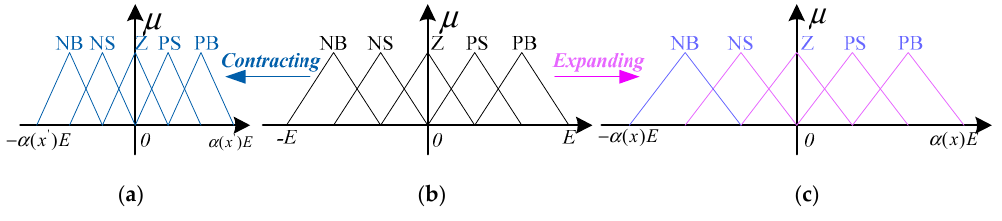
Figure 5. Illustration of variable universe: ( a ) Contracted universe; ( b ) original universe; ( c ) expanded universe.